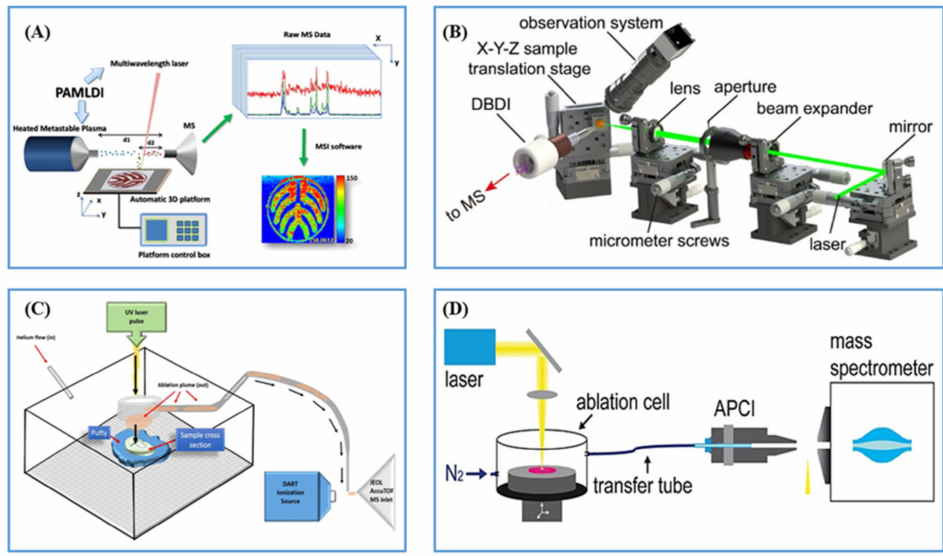
Figure 4. ( A ) Scheme of PALDI ion source. Reprinted with permission from the authors of [60]. Copyright (2014) American Chemical Society. ( B ) Scheme of LADBDI ion source. Reprinted with permission from the authors of [61]. Copyright (2021) American Chemical Society. ( C ) Scheme of LADI ion source. Reprinted with permission from the authors of [63]. Copyright (2017) American Chemical Society. ( D ) Scheme of LAAPCI ion source. Reprinted with permission from the authors of [64]. Copyright (2013) John Wiley and Sons